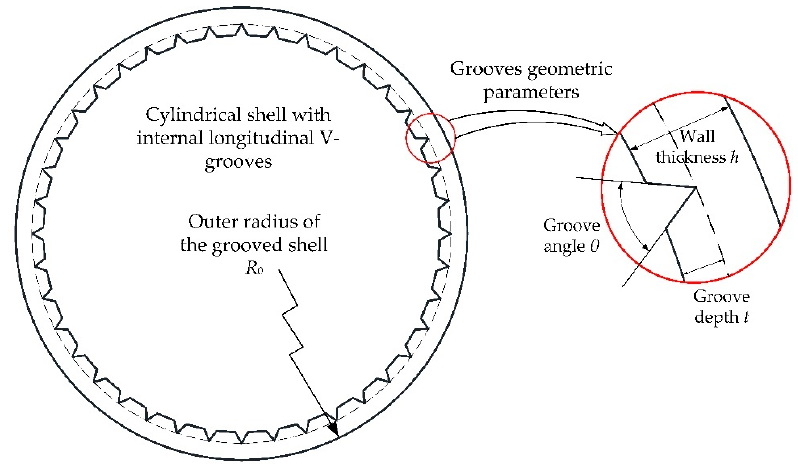
Figure 1. Cross-section of a cylindrical shell with V-grooves machined on the internal surface.